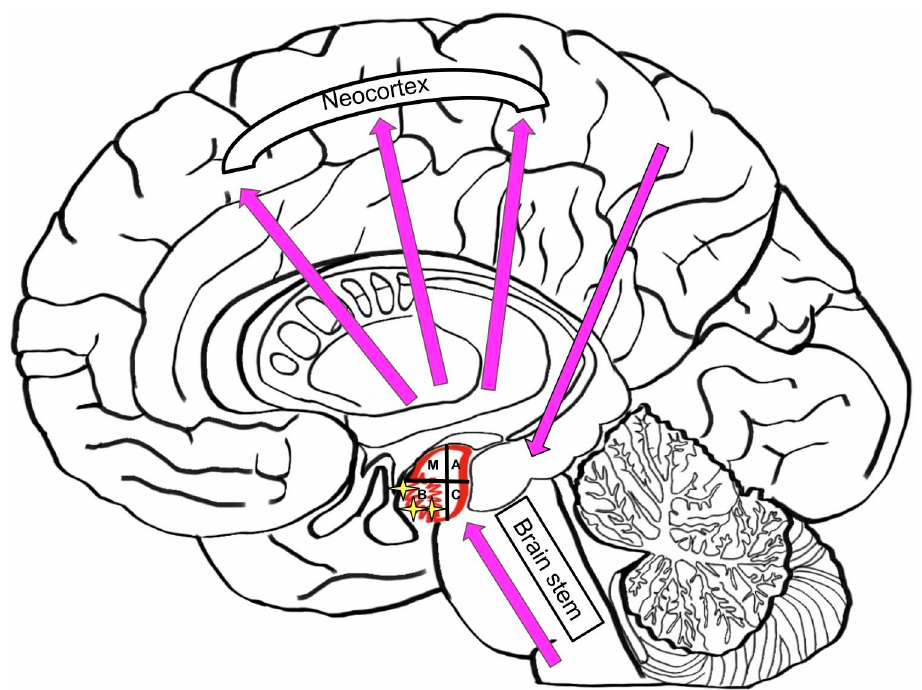
Figure 7. Dysfunctions in the brain effected by Alzheimer’s Disease (M—medial nucleus; A—Accessory nucleus; B—basal nucleus; C—caudal, or lateral nucleus).